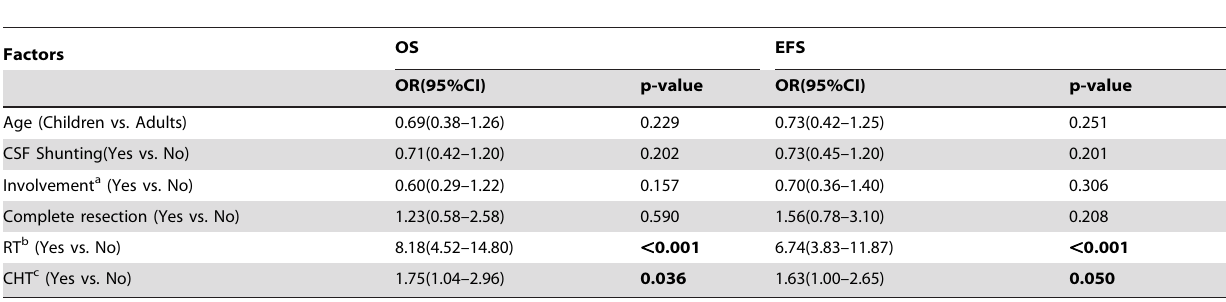
Table 2. Multivariate analysis of prognostic factors for OS and EFS in patients with medulloblastoma (n=173).